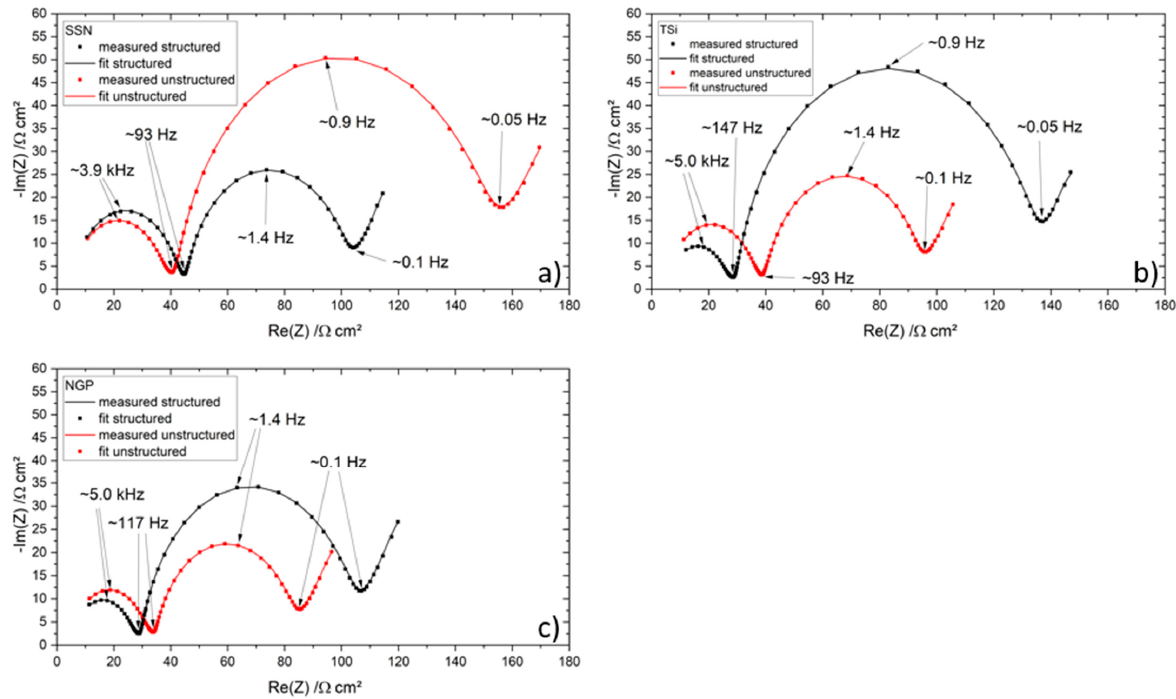
Figure 14. Electrochemical impedance spectra of the pouch cells after EoL and their respective fit: ( a ) SSN, ( b ) TSi, and ( c ) NGP anode.